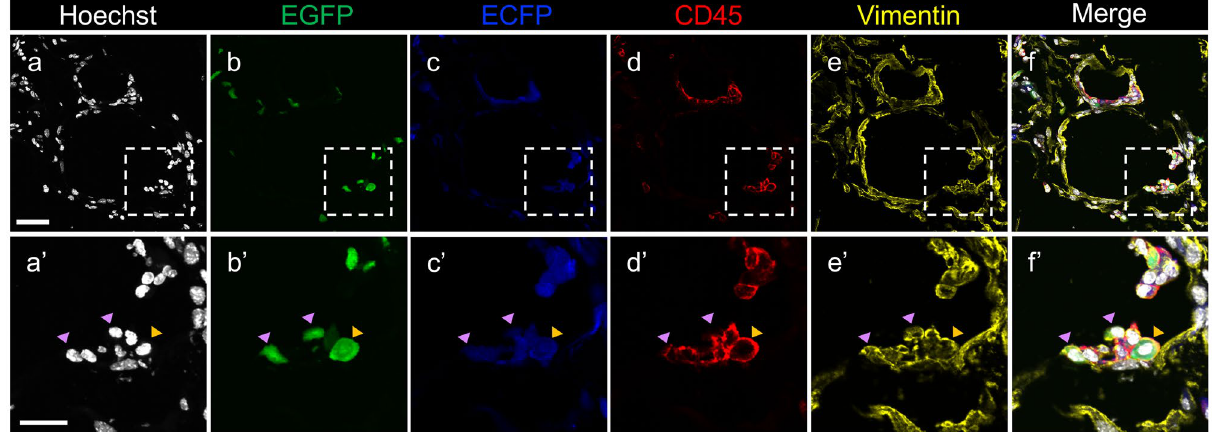
Figure 5. Representative confocal images of the omenta of parabiotic Rosa26 ECFP/ + mice paired with Rosa26 EGFP/ + mice. Rosa26 ECFP/ + mice were paired with Rosa26 EGFP/ + mice and injected with polyacrylamide beads 4 weeks after surgery. Mice were sacrificed 7 days after injection. Images ( a – f ′ ) show the omentum of the Rosa26 ECFP/ + mouse. ( a ) Hoechst nuclear staining. ( b ) Expression pattern of EGFP in the same field as ( a ). ( c ) Expression pattern of ECFP in the same field as ( a ). ( d ) Expression pattern of CD45 in the same field as ( a ). ( e ) Expression pattern of vimentin in the same field as ( a ). ( f ) Merged image of ( a – e ). ( a ′ – f ′ ) shows enlarged images of dotted line squares in ( a – f ). Purple arrowheads indicate CD45 − /Vimentin + cells expressing EGFP. Orange arrowhead indicates CD45 + /Vimentin + cells expressing EGFP. Scale bars = 50